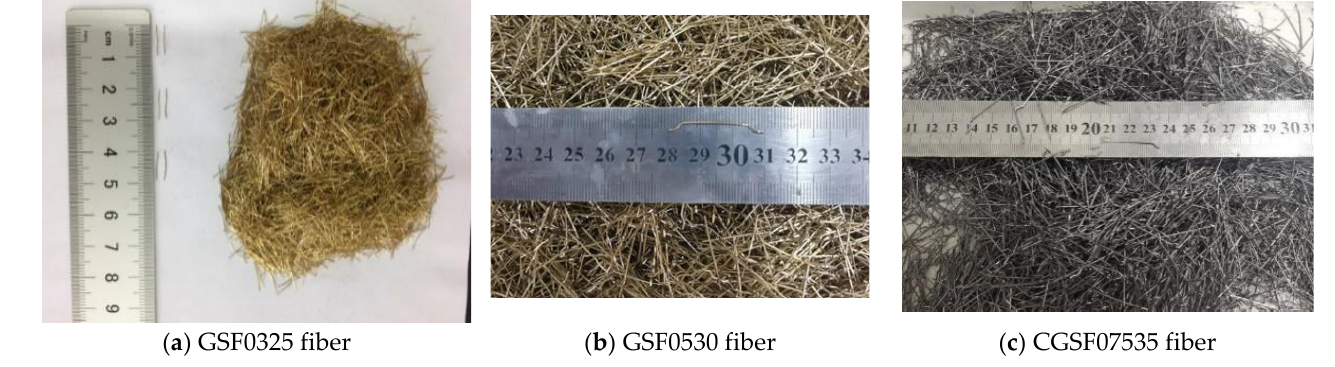
Table 5. Mixture proportions of C80 concrete (kg/m 3 ).